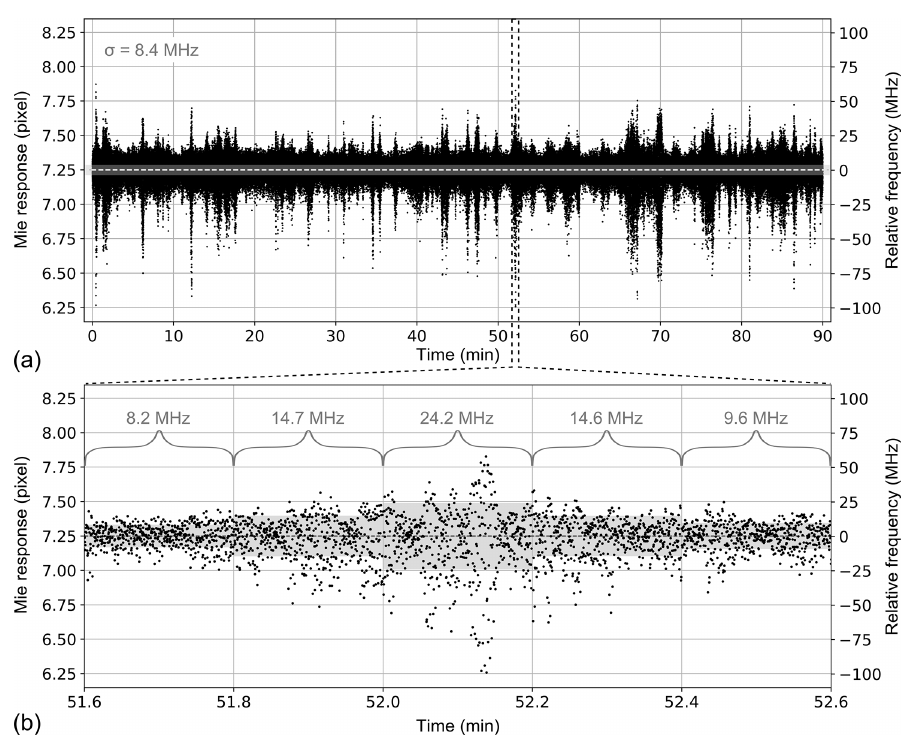
Figure 3. ALADIN laser frequency stability: (a) time series of the laser frequency fluctuations over about one orbit (14 October 2019, 01:27 to 02:57UTC), as measured from the Mie channel of the receiver; (b) close-up of a selected period showing the frequency variations over five observations. The given values denote σ f (N = 540 ) as defined in the text. The standard deviations are also indicated as gray-shaded